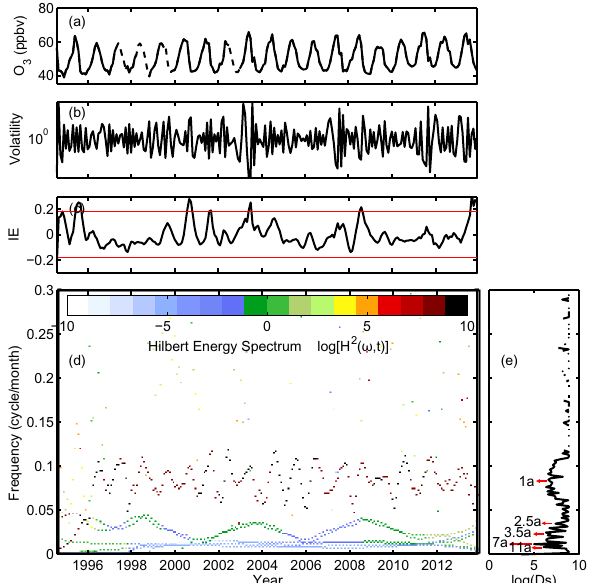
Figure 8. The interpolated monthly average ozone mixing ratio signal at Mt WLG during 1994–2013 (a) , the volatility (b) , the normalised mean value of the instantaneous energy (red lines: ± 2 σ) (c) , Hilbert energy spectrum (d) and the degree of station- arity (e)